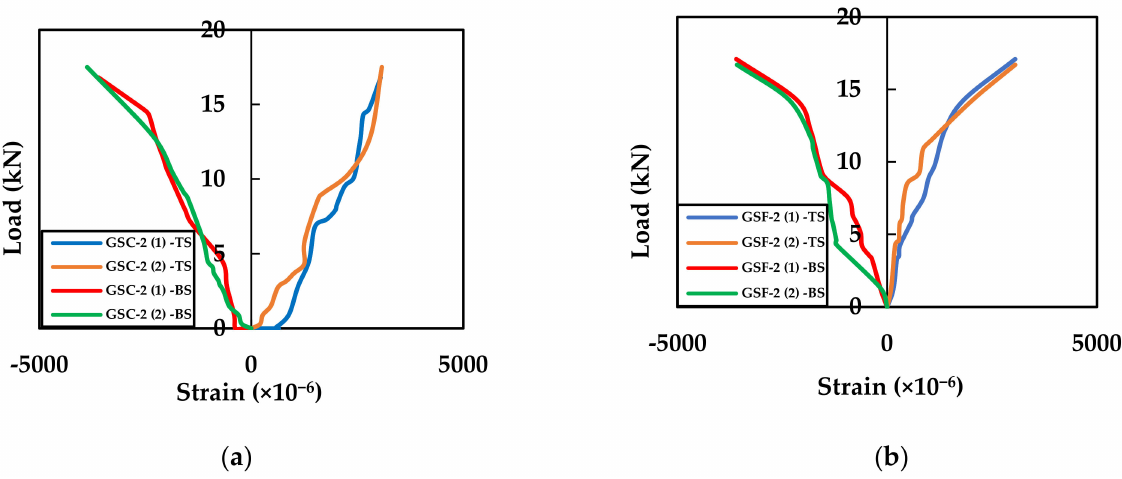
Figure 12. Load–strain behaviour of ( a ) GSC-2 and ( b ) GSF-2. TS—top strain, BS—bottom strain.